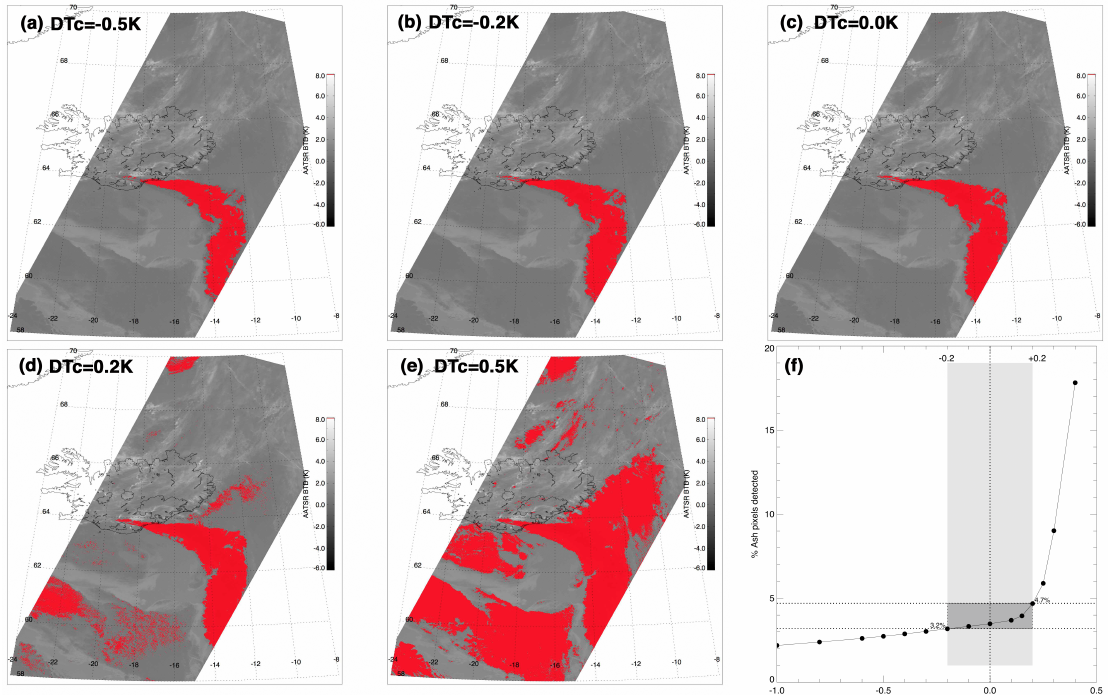
Figure 7. Ash detection based on brightness temperature difference thresholds ( DT c ). ( a ) DT c = − 0.5 K, ( b ) DT c = − 0.2 K, ( c ) DT c = 0.0 K, ( d ) DT c = +0.2 K, ( e ) DT c = +0.5 K. ( f ) The variation of the number of pixels classified as ash (in %) as a function of DT c